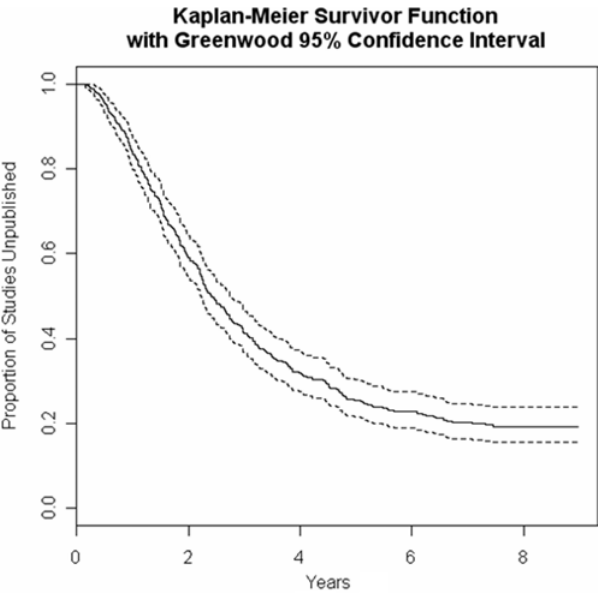
Figure 2. Kaplan-Meier Curve for the time to publication of Cochrane reviews and 95% confidence intervals. The Kaplan- Meier Curve displays that the proportion of unpublished Cochrane reviews decreases over